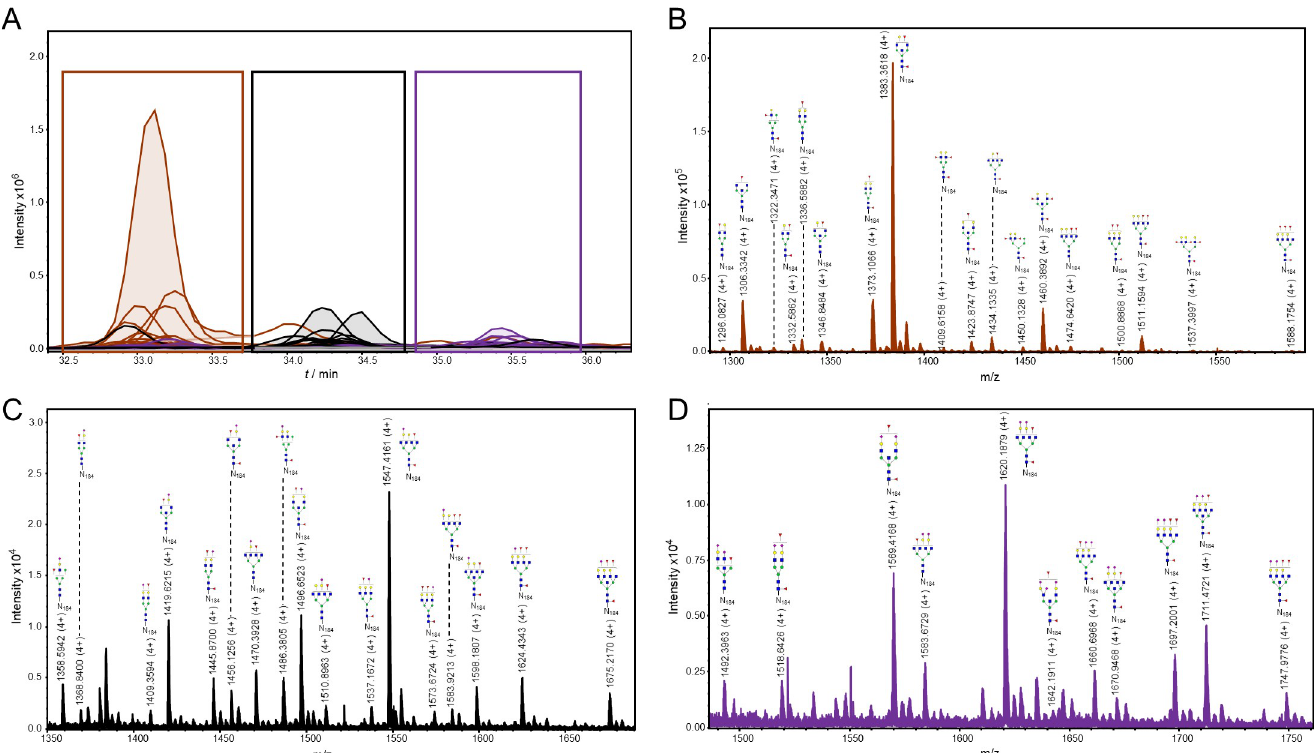
Fig 3. Representation of detected glycoforms on the N-184 glycosylation site of 21K slow prion strain. A) Extracted ion chromatograms with mutual 46 glycoforms detected. B) Assigned glycoforms in MS spectrum with N-184 peptide backbone: neutral, C) monosialylated and D) disialylated (together with one trisialylated glycoform). Blue square–N-acetylglucosamine (GlcNAc), green circle–mannose (Man), red triangle–fucose (Fuc), yellow circle–galactose (Gal), purple diamond–N-acetylneuraminic acid (Neu5Ac).